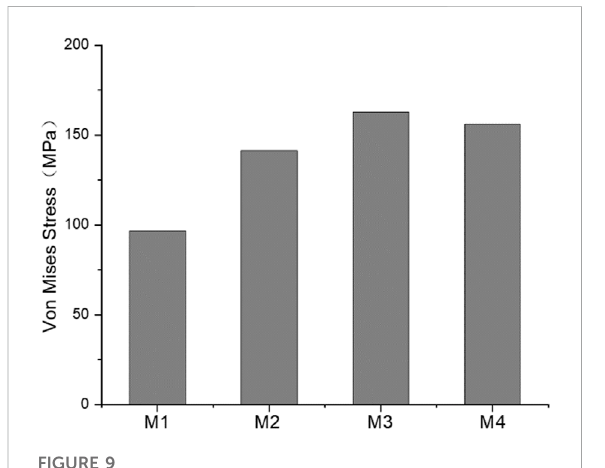
FIGURE 11 UIV and UIV+1 stress nephogram of M1 – M4